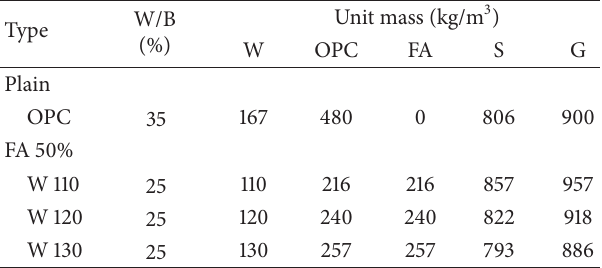
Table 4: Mixing proportion of concrete in